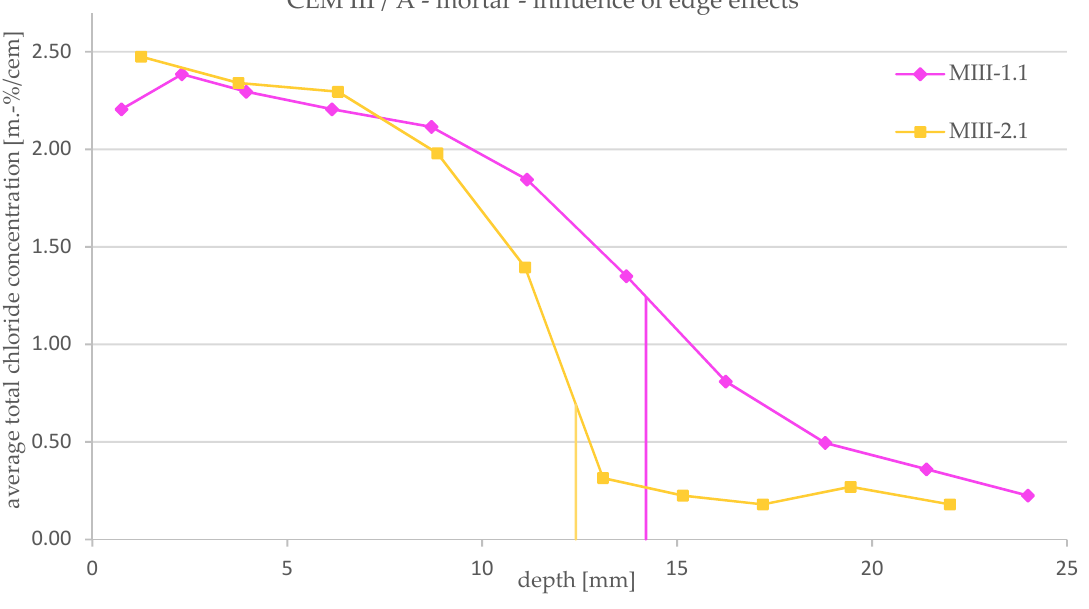
Figure 8. Influence of edge effects on total chloride concentration profiles obtained after an RCM test for CEM III/A mortar specimens (specimen no. MIII-1.1 analyzed concrete powder with edge effect; MIII-2.1 analyzed concrete powder without edge e ff ect).